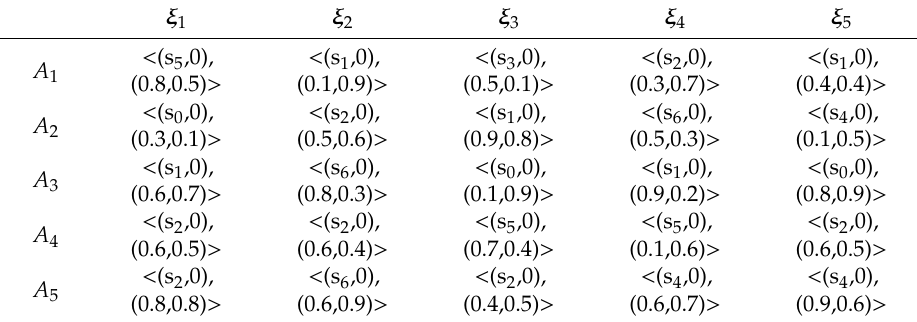
Table 1. P2TLN decision matrix by DM 1 .